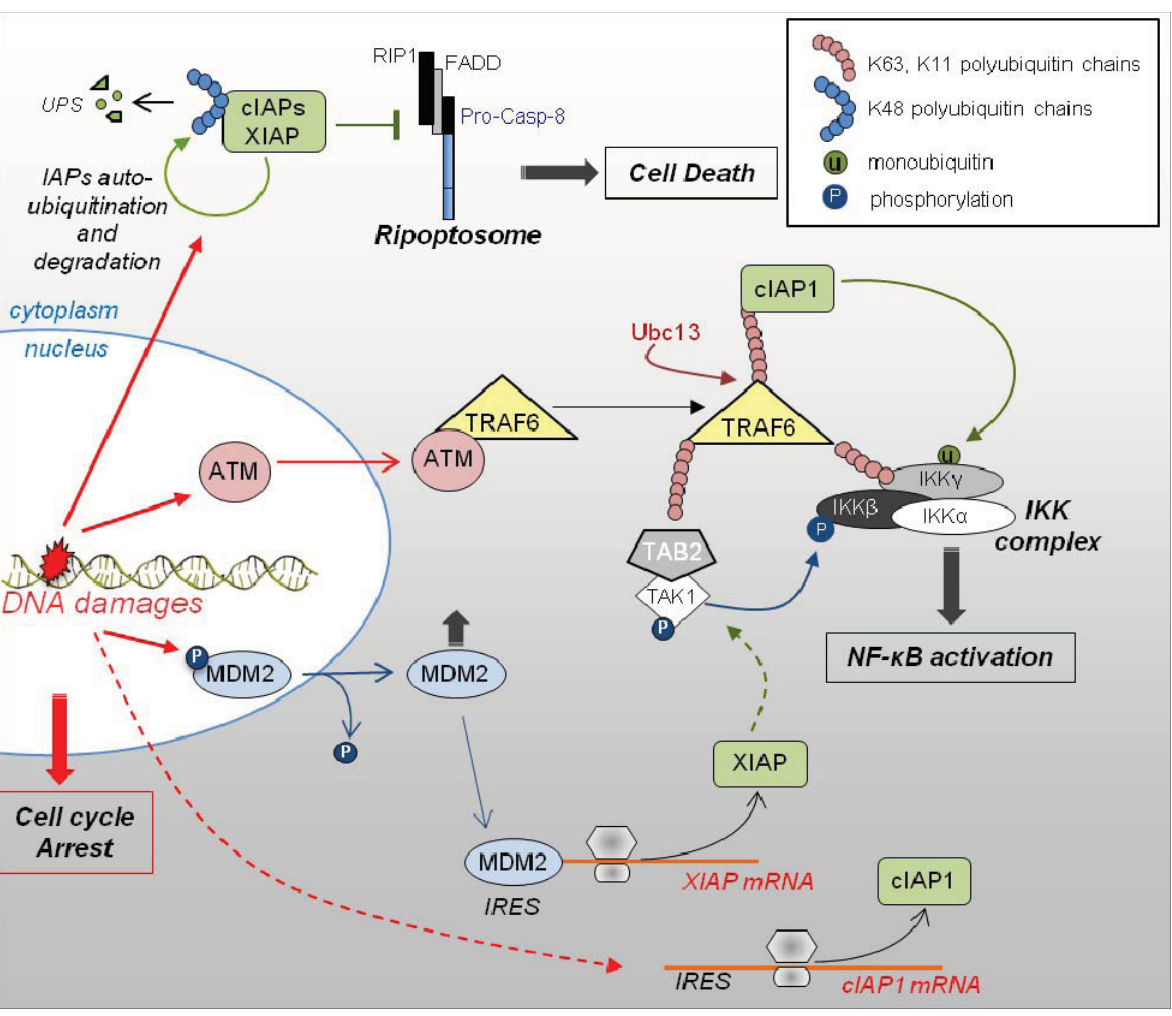
been described, allowing the assembly of Ripoptosome leading to caspase-dependent